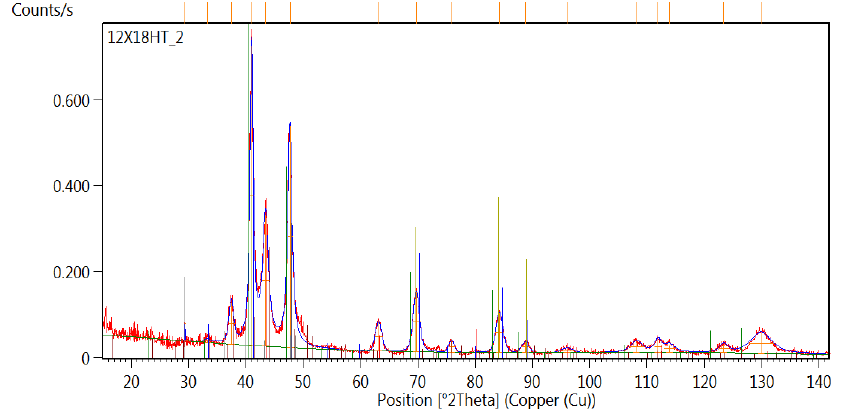
Figure 6. X-ray diffraction pattern of a nitrided layer on a 12X18H10T steel specimen manufactured by the LB-PBF.